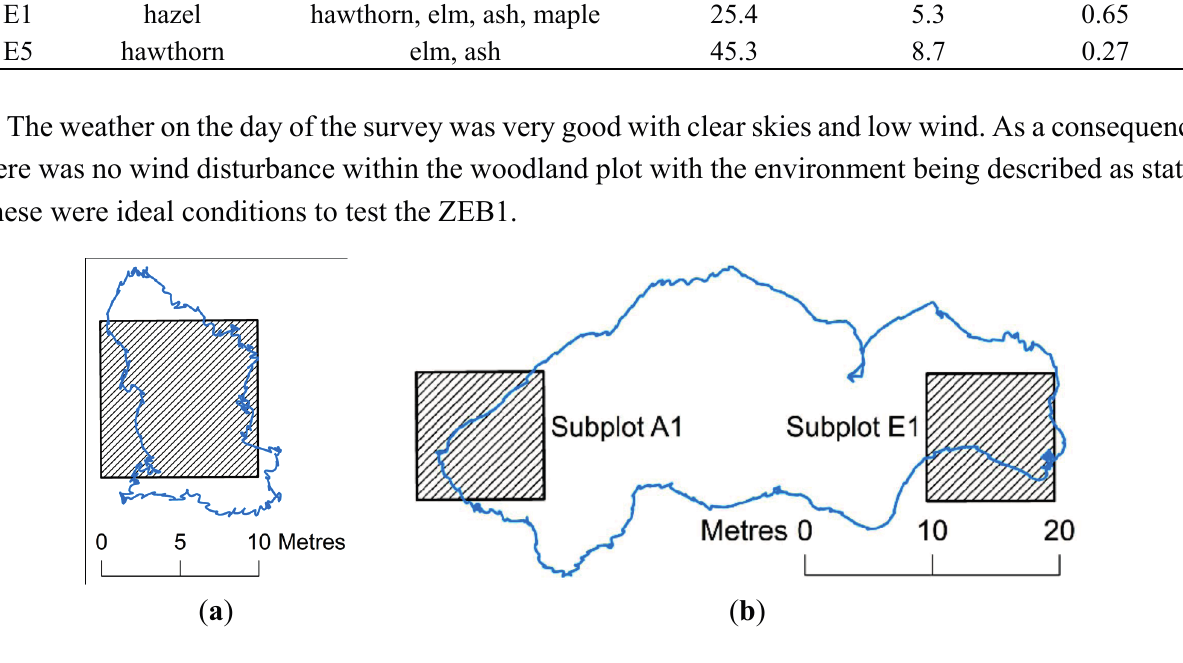
Figure 3. Trajectory for HMLS survey of ( a ) subplot A1 and ( b ) zone between